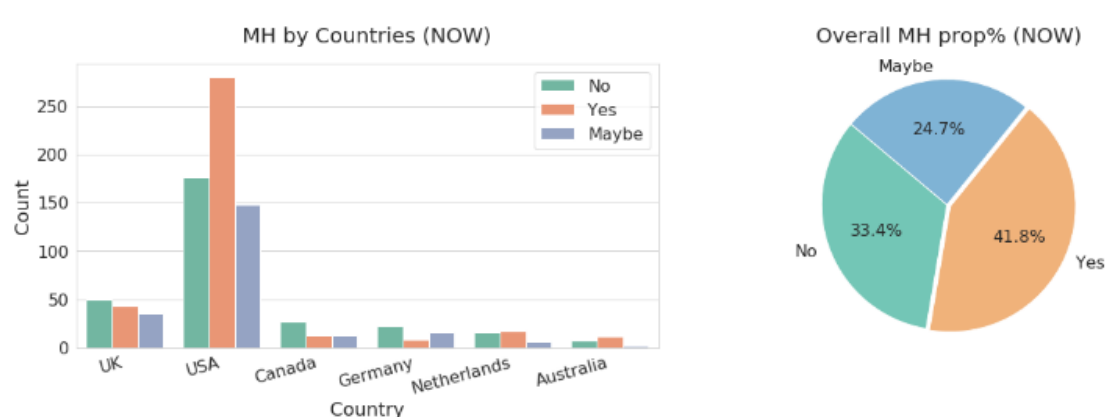
Figure 5: Mental Health Disorder in Tech companies with overall percentage proportion (currently) in tech in this survey in the United States (US) is the biggest one out of all countries. Figure 4 shows the gender of the participants per country, and Figure 5 is the mental health disorder in Tech. companies with overall percentage proportion. The results in Figure 6 show that there are tech workers with ParadigmPlus (2022)